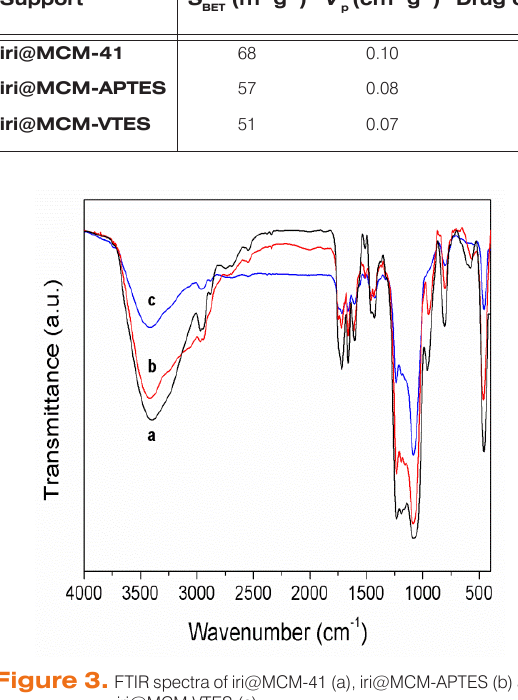
Table 2. Features of irinotecan-based hybrids. Support